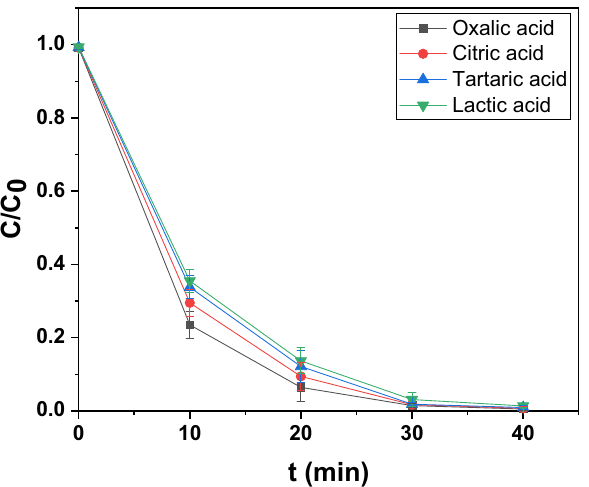
Figure 15. Photodegradation dynamic curves of esomeprazole in presence of different organic acids over In 2 O 3 /MoS 2 /Fe 3 O 4